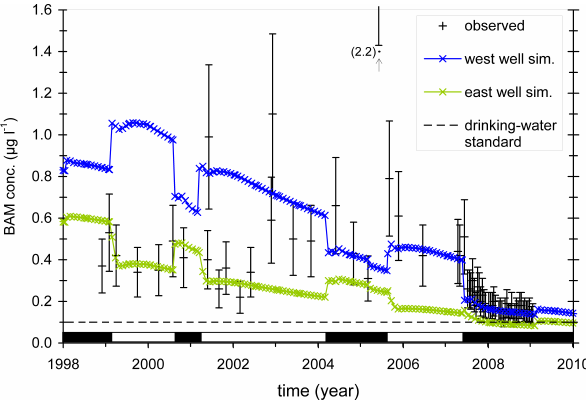
Fig. 7. Calculated infiltration rates (rainfall+snowmelt − evapo- transpiration; left y-axis) and bottom water fluxes at 10.2m depth (right y-axis). The daily water outflows were generated by the va- dose zone model from 1 July 2003 to 30 June 2004. The indicated date of calibration refers to 1 November